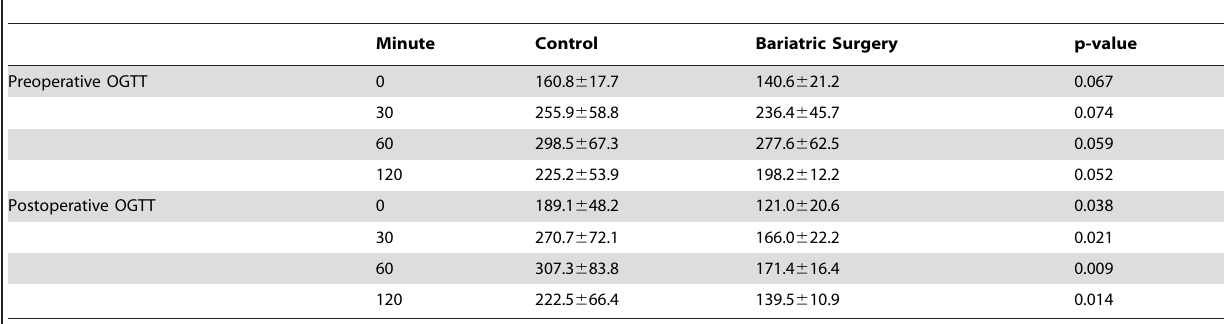
Table 1. Preoperative and postoperative oral glucose tolerance test (OGTT).